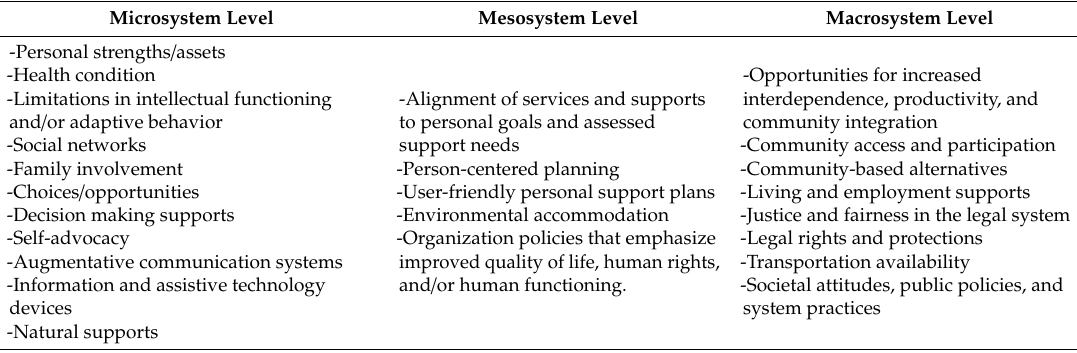
Table 1. Factors that influence quality of life, human rights, and / or human functioning